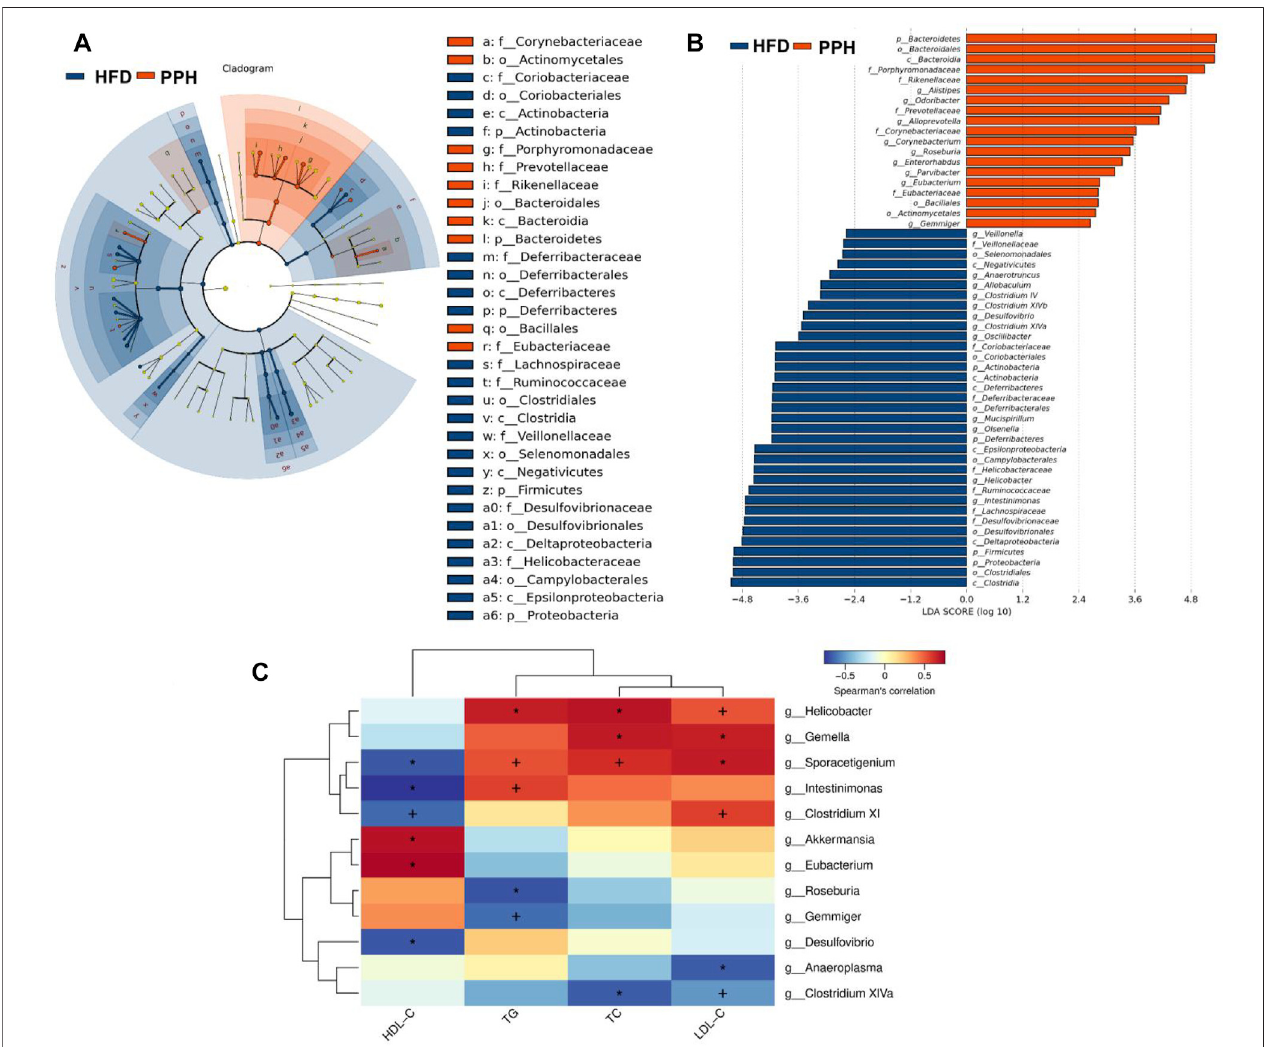
FIGURE9| EffectsofPPHtreatmentonphylotypesofcolonicmicrobiotaanditscorrelationwithphysiologicalparameters.LEfSecomparisonofcolonicmicrobiota betweentheHFDand thePPHgroup: Taxaenriched intheHFDgroup(darkblue)and PPHgroup(orange) (A) ;onlythosemeetingtheLDA scorethreshold > 2arelisted (B) . Heat map of Spearman ’ s correlations between colonic bacteria and TC, LDL-C, TG, and HDL-C (C) . Correlation between biomarkers and microbial species was visualized by color depth: the darker the color, the higher the relevance. + p < 0.05 and * p < 0.01.